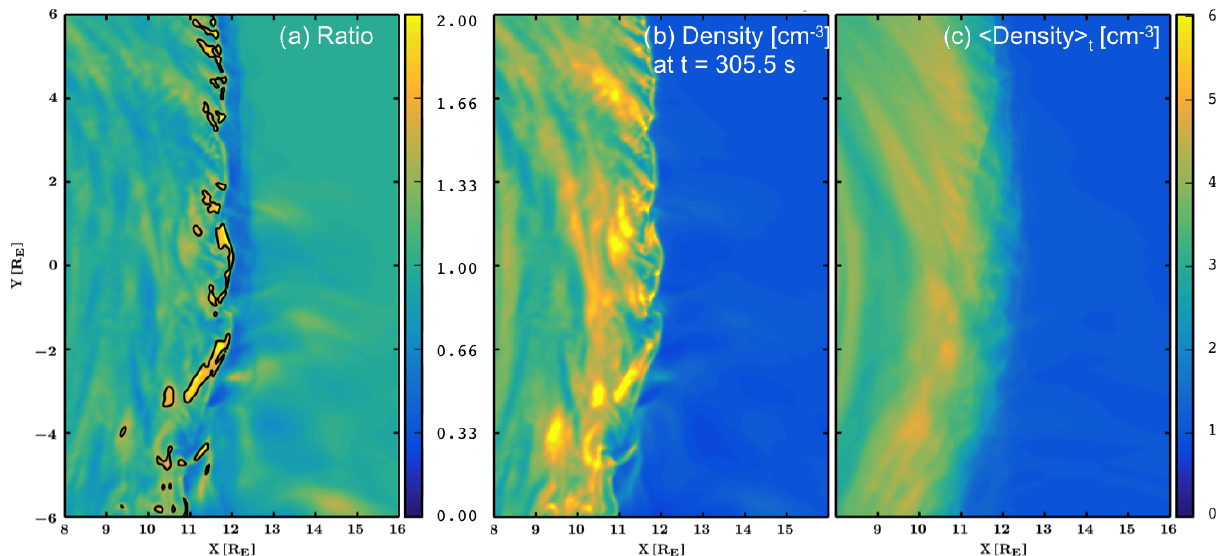
Figure 4. (a) The Karlsson criterion in Eq. (3) (Karlsson et al., 2012, 2015), devised from the ratio of (b) the density at t = 305 . 5s and the (c) temporal average of density over 3min, centered at the time showing the jet-like feature in Fig. 1a. Panel (a) shows a contour marking locations where the ratio of panel (b) and (c) exceeds 1.5. Panels (b) and (c) have the same scale, from 0 to 6 particles in a cubic